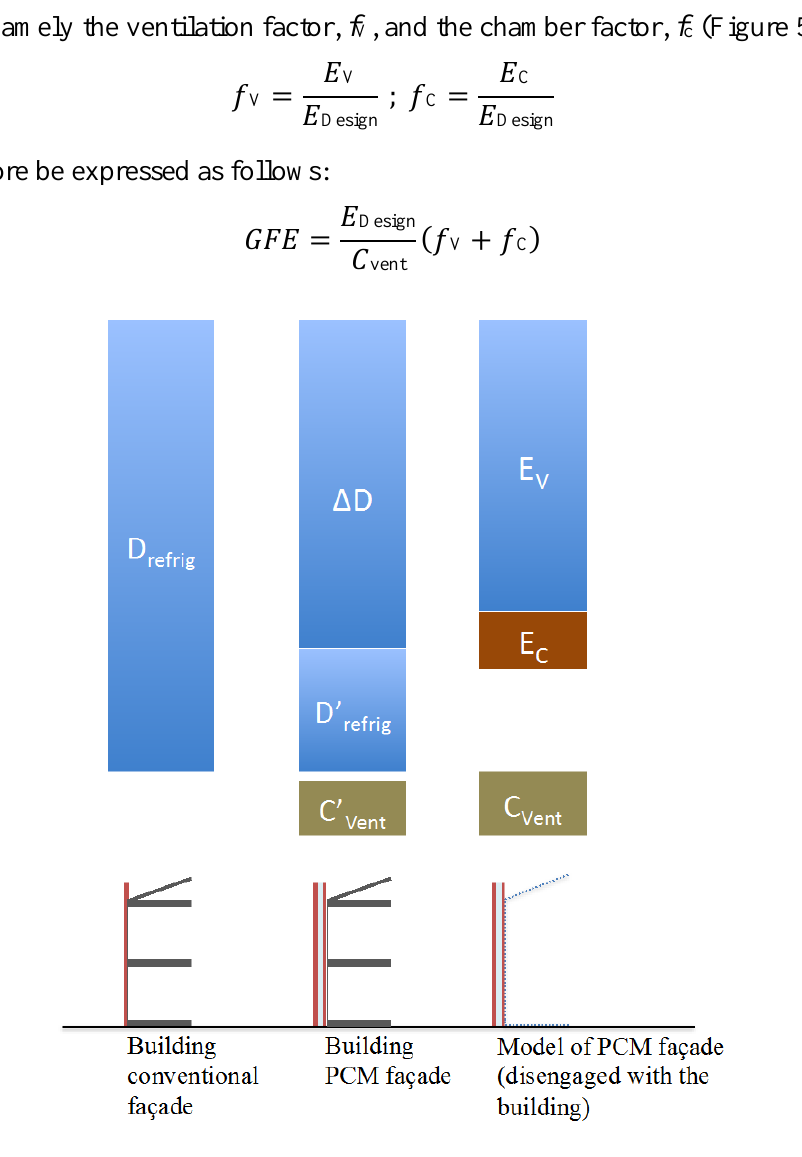
Figure 5. Façade energy diagram. PCM: phase change